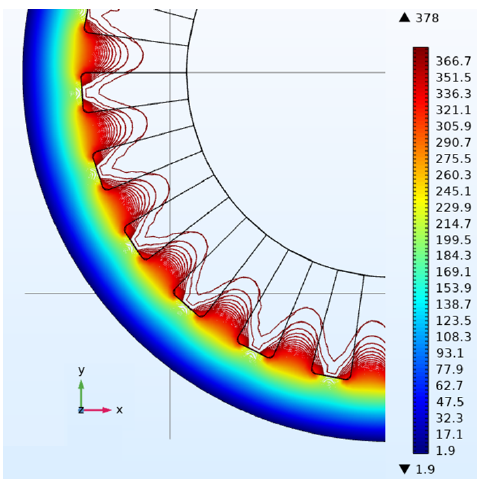
Figure 7. Contour electrical potential distribution.